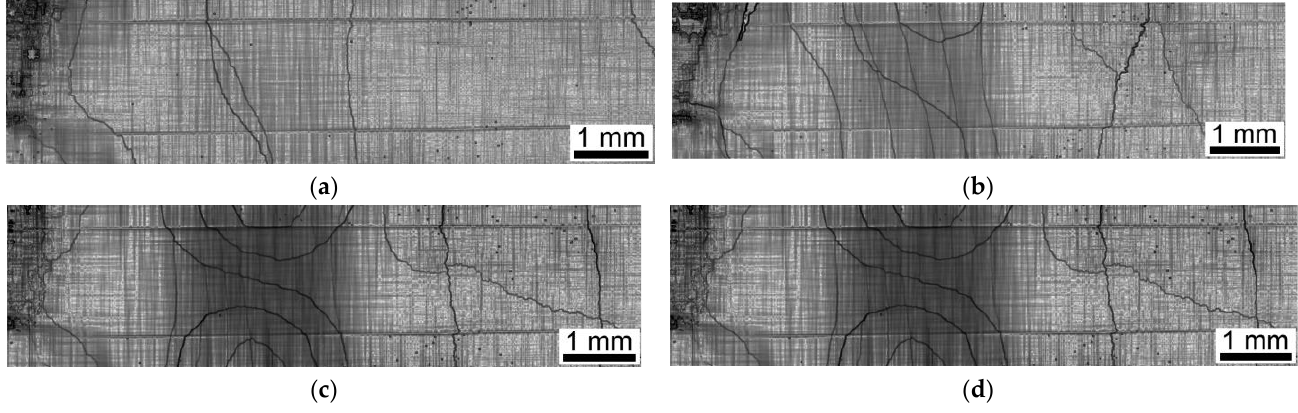
Figure 9. Evolution of deformation structures at the first stage ( a – d ): ( a ) ε = 0.025, ∆ ε = 0.008; ( b ) ε = 0.029, ∆ ε = 0.020; ( c ) ε = 0.037, ∆ ε = 0.012; ( d ) ε = 0.029, ∆ ε =